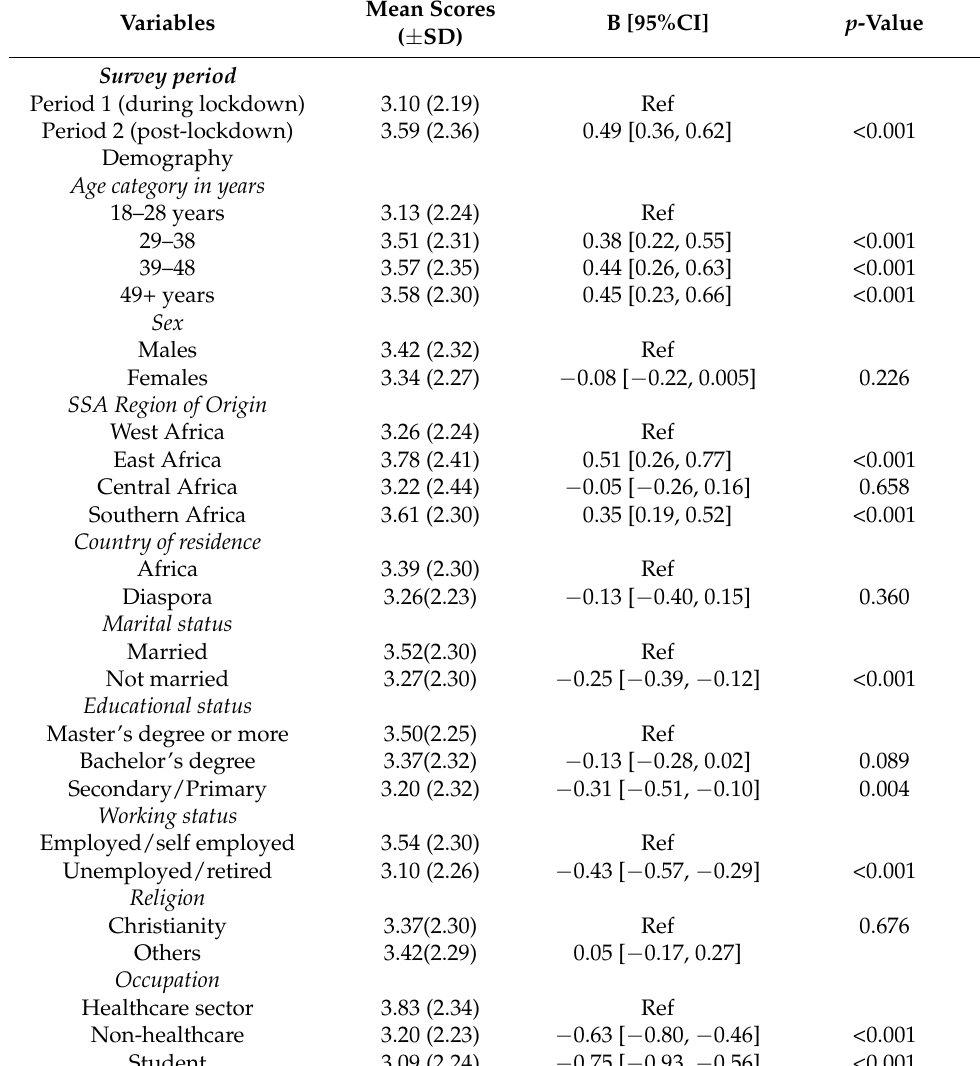
Table 2. Mean scores and unadjusted coefficients (B) for factors associated with perceived risk of contracting COVID-19 during lockdown and